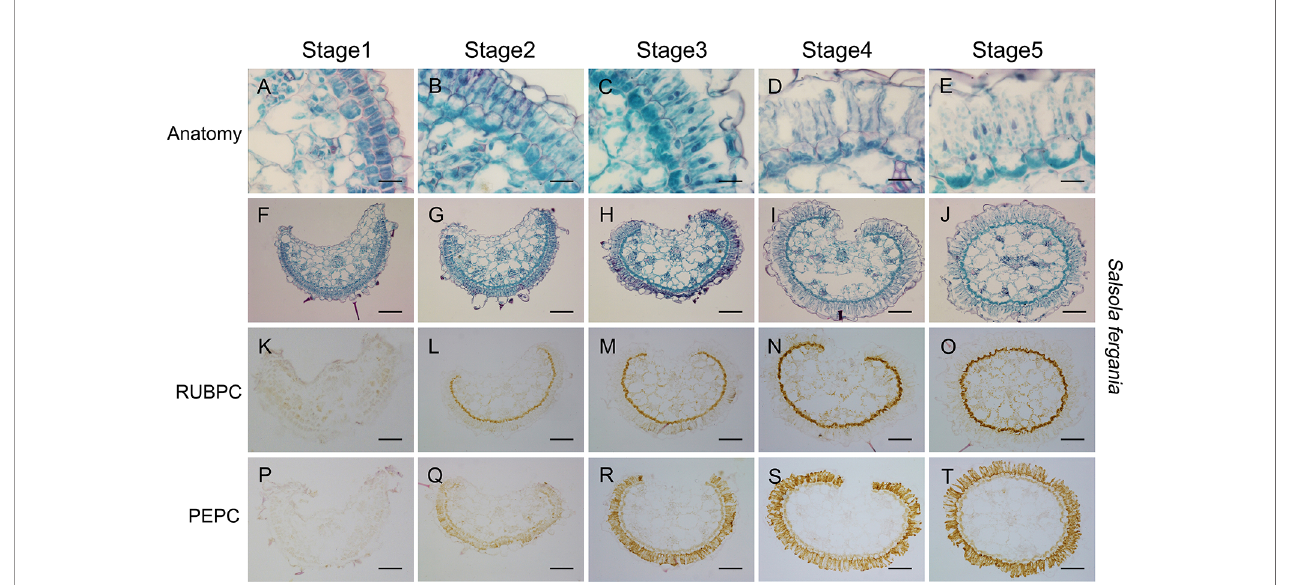
FIGURE 8 | Anatomic structure of leaf and in situ immuno-histochemical localization (ISIHL) of RUBPC and PEPC of S. ferganica with transverse sections in the middle part of leaves at different developmental stages, showing a developmental gradient of structure differentiation. (A – J) Anatomic structure; (K – T) ISIHL results; (A – E) Middle part of transverse sections of leaf at different developmental stages (0.2 cm, 0.5 cm, 1.0 cm of leaf); (F – J) Detailed views of bundle sheath and mesophyll cells corresponding to images in A – E; (K – O) ISIHL of RUBPC (RBCL) corresponding to images in A – E; (P – T) ISIHL of PEPC corresponding to images in A – E. BS, bundle sheath; E, epidermis; H, hypodermis; M, mesophyll; VB, vascular bundle; WS, water storage. Scale bar in A – E is 25 µm; in F – T is 100